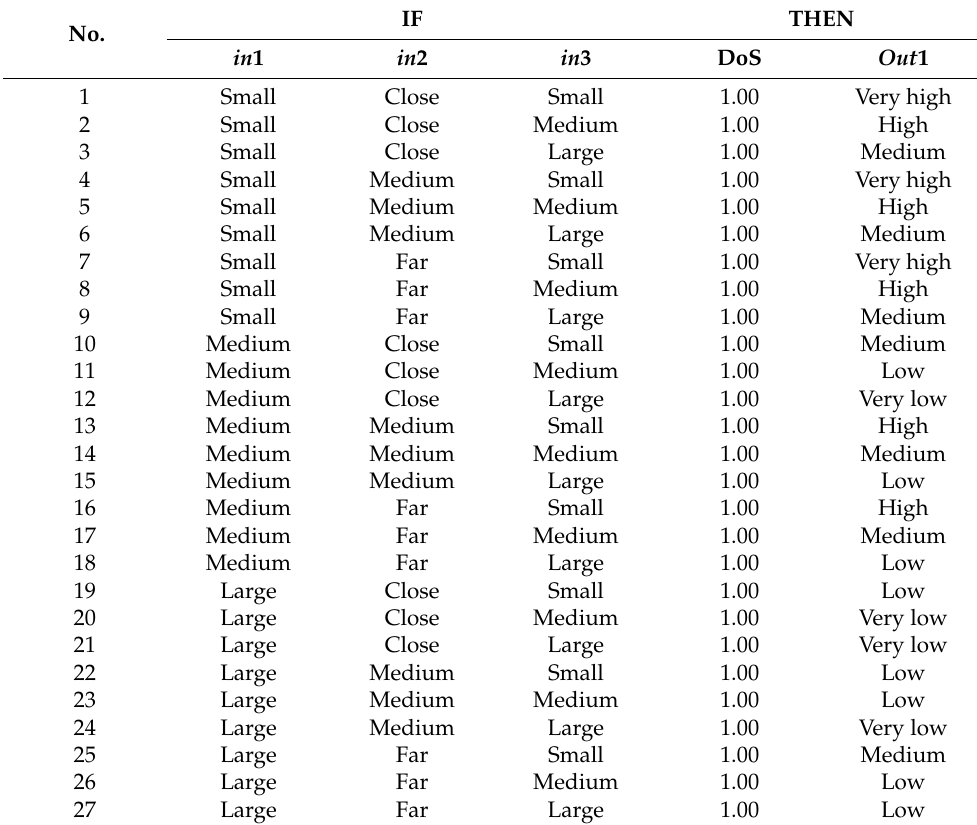
Table 3. Matching the grades of the output and input